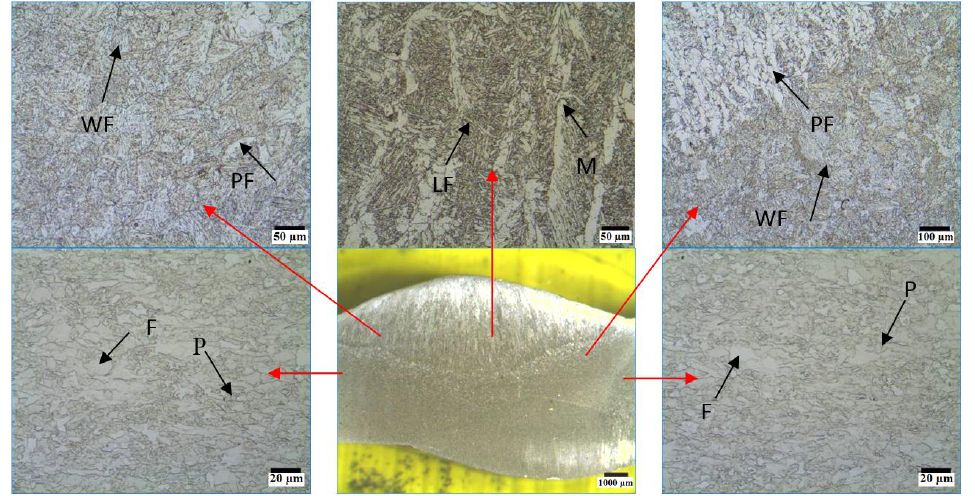
Figure 2. Microstructure of welded sample S1: ferrite (F), pearlite, (P), plate ferrite (LF), martensite (M), polygonal ferrite (PF) and witmanstaten ferrite (WF).